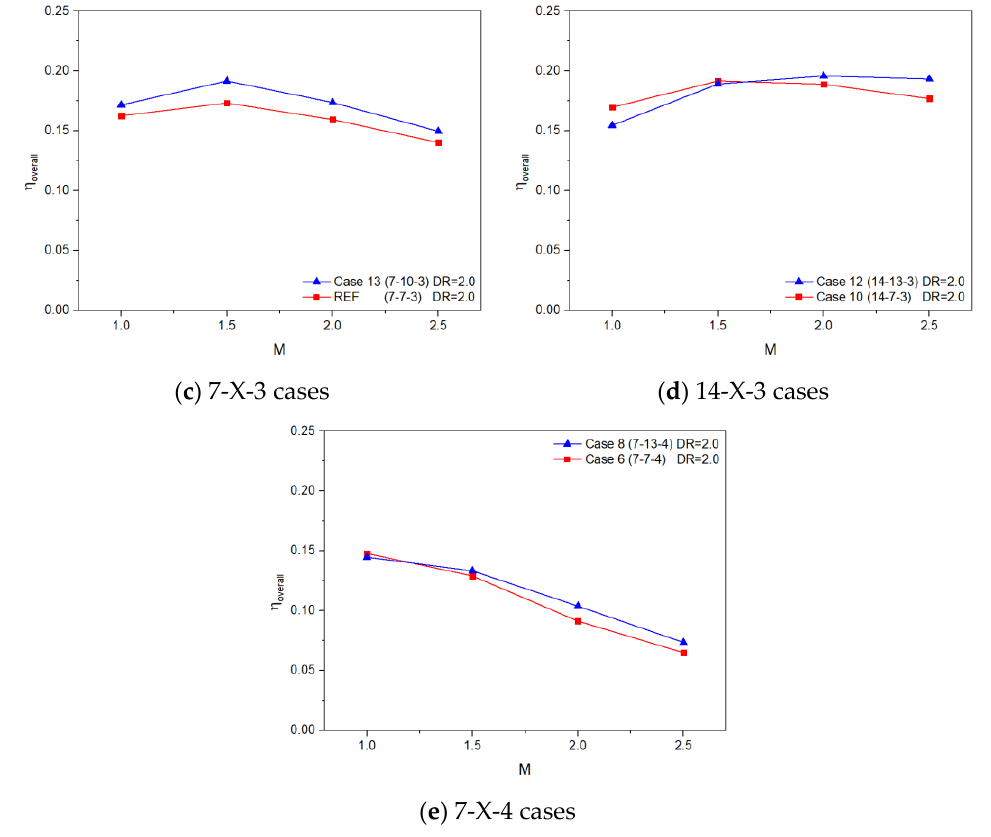
Figure 10. Overall averaged FCE for β lat .